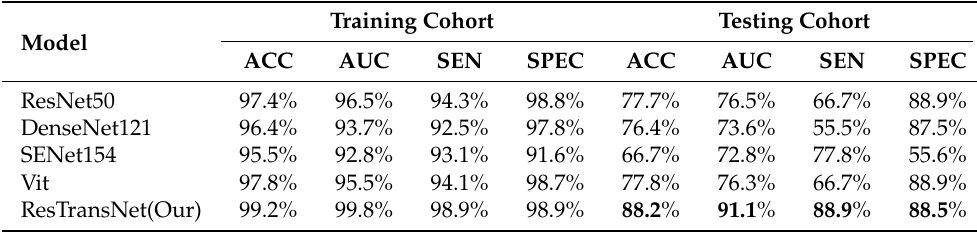
Table 2. We report the performance of the proposed model with average accuracy. ResNet50, DenseNet121, and SENet154 are standard convolutional neural networks, while Vit is a standard transformer network. ResTransNet is the proposed network, including convolution and transformer. Training Cohort Testing Cohort Model ACC AUC SEN SPEC ACC AUC